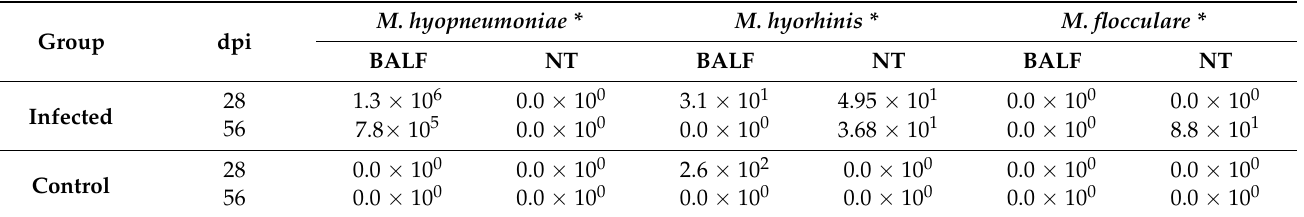
Table 2. Mean M. hyopneumoniae , M. hyorhinis , and M. flocculare DNA quantification values (copies/ µ L) in bronchus-alveolar lavage fluid (BALF) and nasal turbinate (NT) samples based on treatment group and day post-inoculation (dpi).